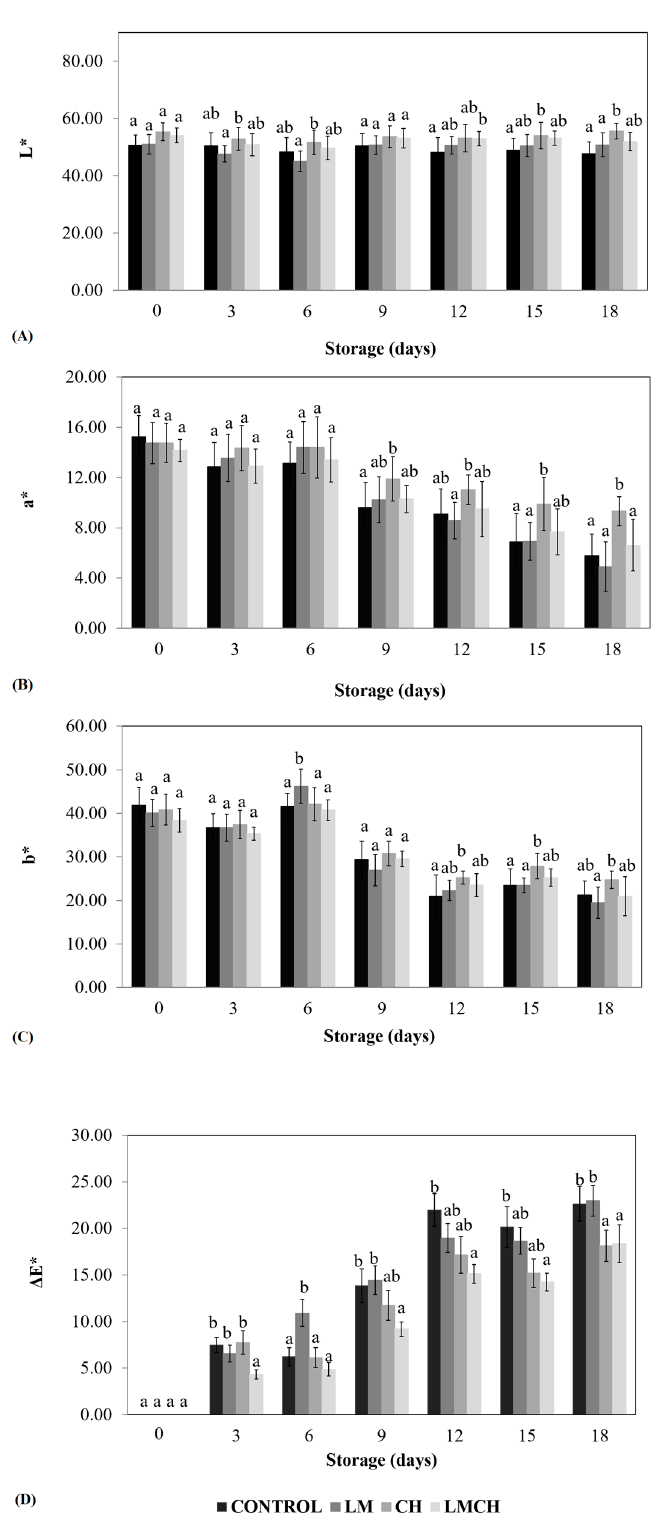
Figure 2. Color attributes—( A ) L *, ( B ) a *, ( C ) b *, and ( D ) Δ E *—of fresh-cut cantaloupe with and without an edible coating (control) during 18 days of storage at 4 °C. Means which do not have a common letter (a, b, c) are significantly different ( p ≤ 0.05). Vertical bars represent ± SD.